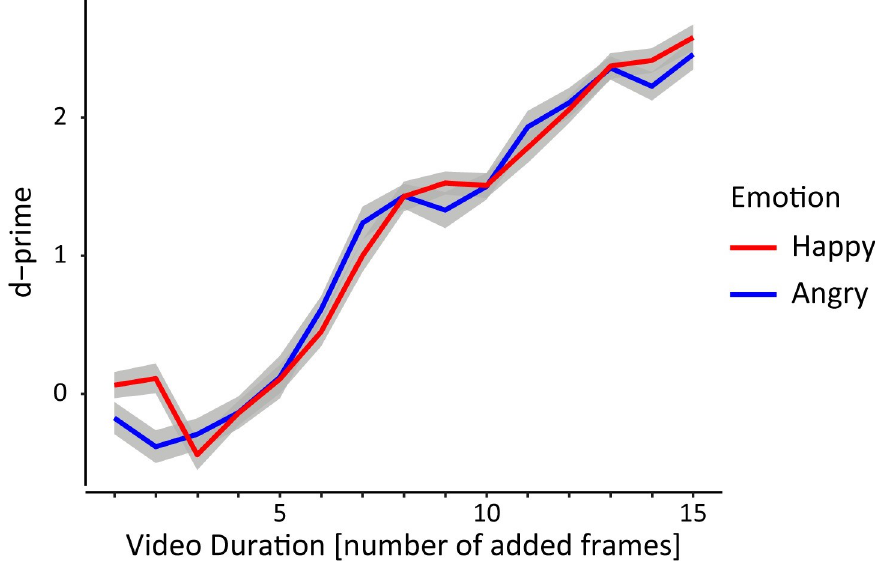
Fig 2. D-prime as a function of and video duration and facial emotion. D-prime values as a function of video duration in number of added frames and facial emotion of the agents (angry, happy). Shaded areas depict the standard error of the